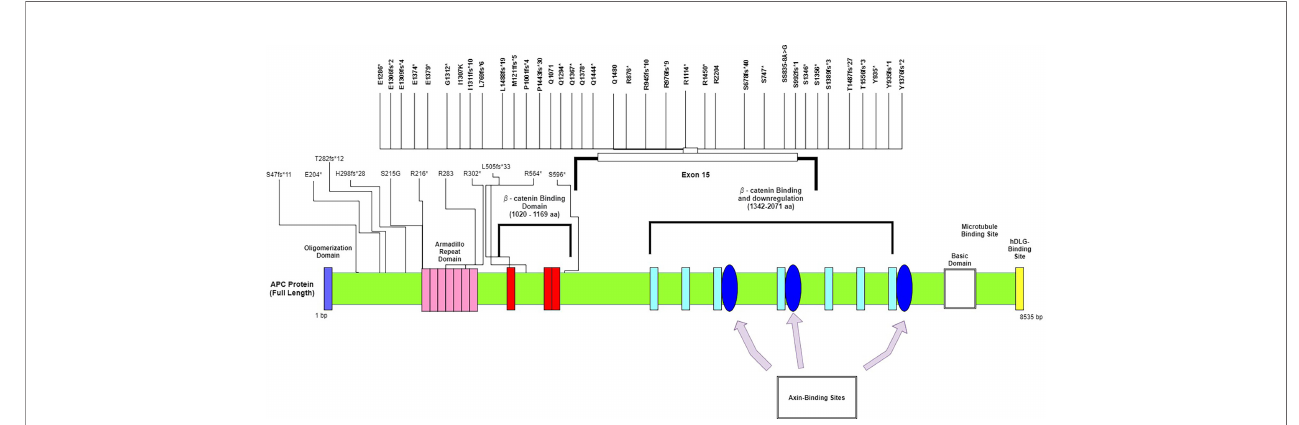
FIGURE 1 | Mutational spectrum of APC in mCRC. The fi gure showed protein domains and the positions of speci fi